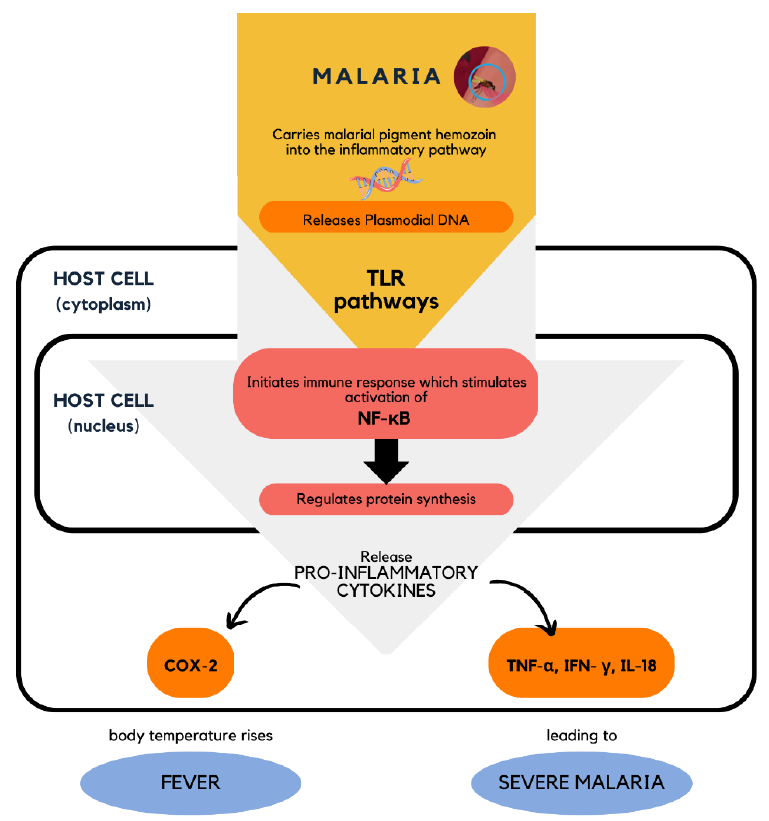
Figure 20. Cellular level mechanism of action of malarial infection in the host cell involving the activation of NF- κ B [79].